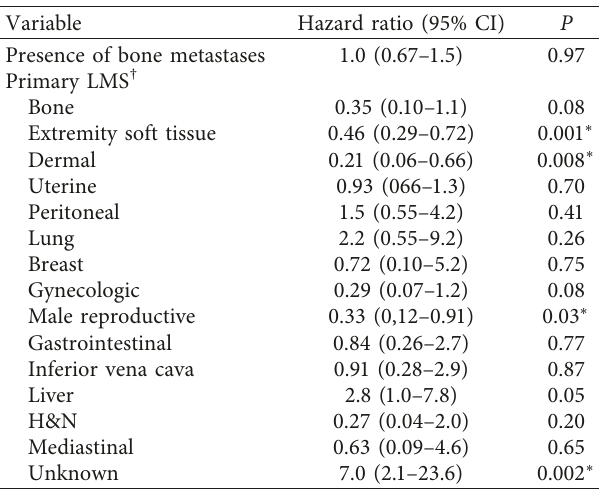
Figure 3: Kaplan–Meier survival curves by overall survival of patients with leiomyosarcoma without bone metastasis compared to those with bone metastases. Vertical hash marks represent censored patients. Table 4: Cox regression analysis of survival in 396 patients with